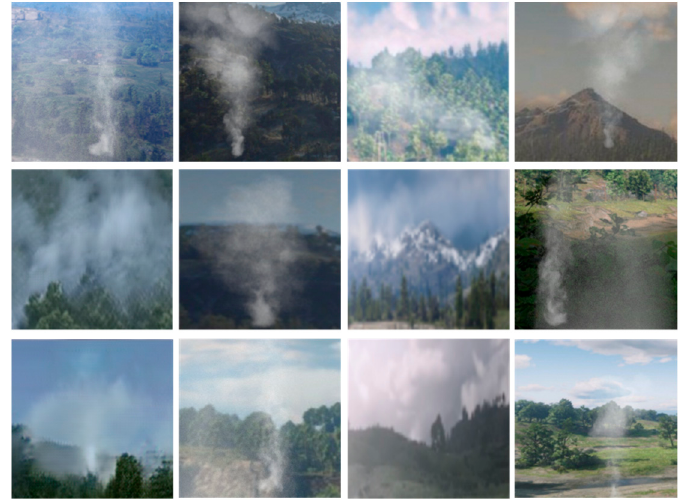
Figure 3. Samples of synthetic images.